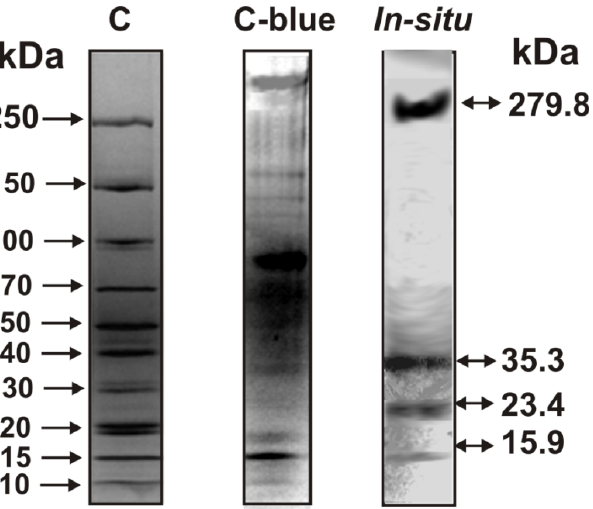
Figure 6. In situ assay of DNase activity of proteins of a stable complex (15 µg) using reducing conditions. DNase activity was revealed as dark bands on the fluorescent background (lane in situ) by ethidium bromide staining. A part of the gel corresponding to the destructed complex was stained with Coomassie R250 to show the position of complex proteins (lane C-blue). Lane C cor- responds to proteins with known MWs. See Materials and Methods for further details.